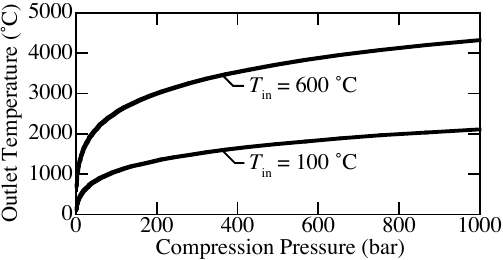
Figure 6. Exit temperature for isentropic compression from 1 to 1000 bar at inlet temperatures of 100 ◦ C and 600 ◦ C. Recommended use of the Helmholtz EOS is for temperatures below 727 ◦ C